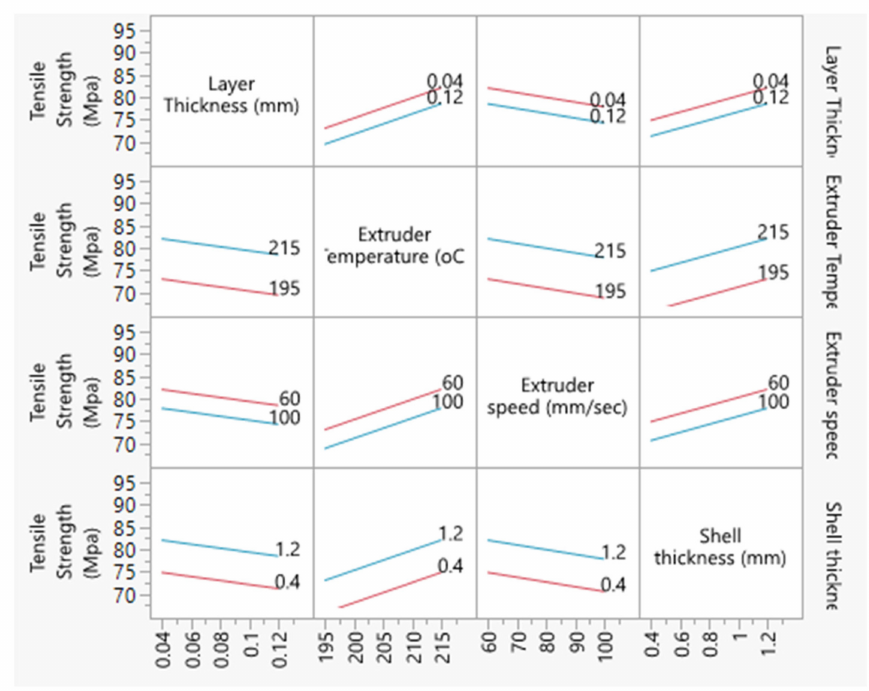
Figure 17. Interaction plot. From the experimental results, the maximum tensile strength of 78.8 MPa was obtained by maintaining the optimum process parameters values, i.e., layer thickness of 0.06 mm, extruder temperature of 210 ◦ C, extruder speed of 60 mm/s, and shell thickness of 1.2 mm. From the desirability plot shown in Figure 18, the maximum tensile strength that could be obtained was 82.03 MPa using the following process parameters values: layer thickness of 0.04 mm, extruder temperature of 215 ◦ C, extruder temperature of 60 ◦ C, and shell thickness of 1.2 mm. It was observed that maintaining a minimum layer thickness and increasing the number of layers increased the density and also enhanced the bonding strength between the layers of PLA. The maximum extruder temperature of 215 ◦ C and the minimum extruder speed of 60 mm/s increased the curing time and stabilized the printed layer in order to receive further material deposition over it. The maximum shell thickness of 1.2 mm provided protection against external loads over the printed layers, which maximized the tensile strength of